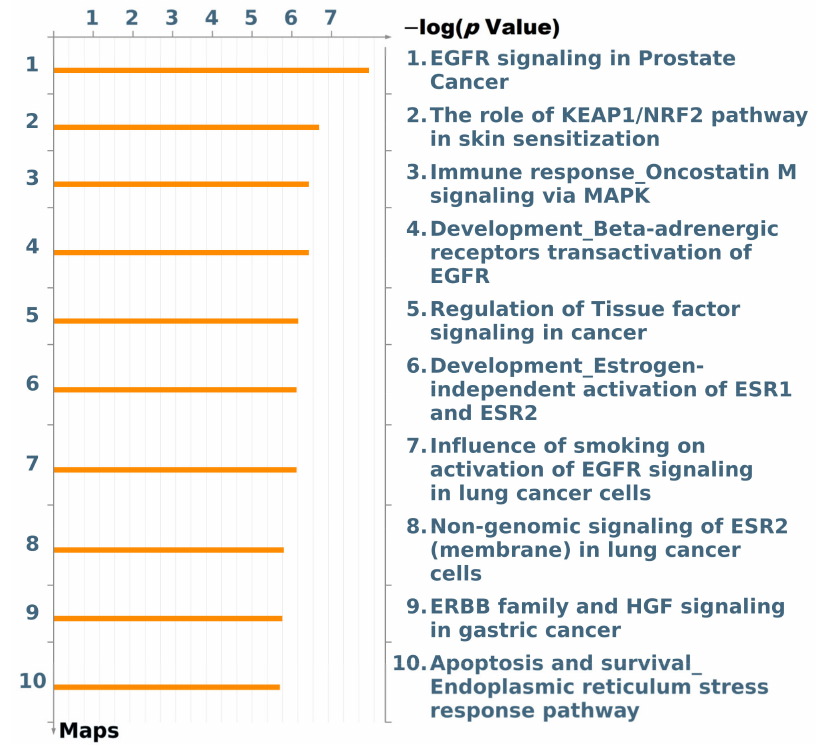
Figure 7. The map of top 10 pathways associated with the top differentially expressed genes. EGFR, epidermal growth factor receptor; KEAP1, Kelch-like ECH-associated protein 1; NRF2, nuclear factor erythroid 2-related factor 2; MAPK, mitogen-activated protein kinase; ESR1, estrogen receptor 1; ESR2, estrogen receptor 2; HGF, hepatocyte growth